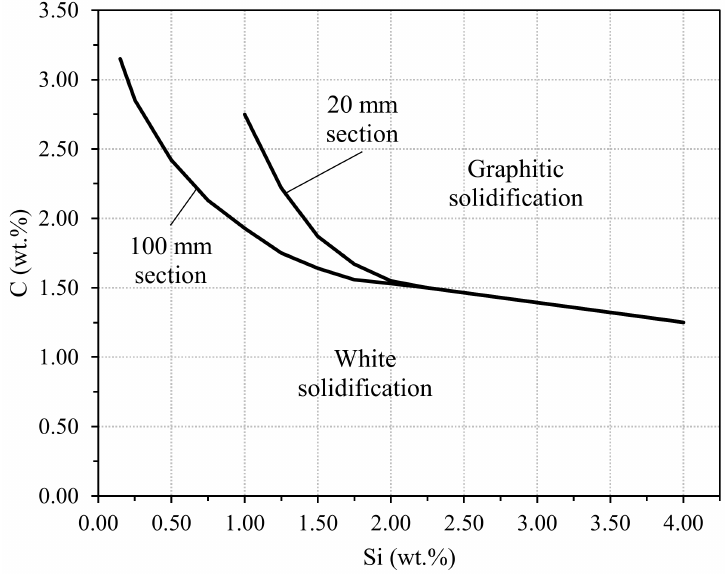
Figure 75. Effect of carbon and silicon contents on solidification of cast iron alloys prepared to manufacture malleable iron castings